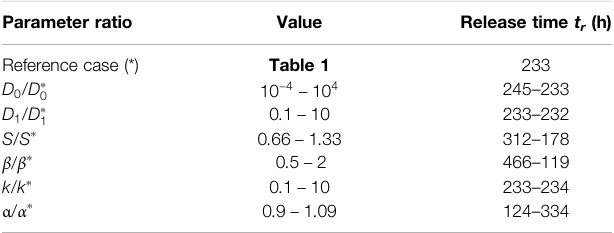
TABLE 2 | Parameter variations over the reference case and their in fl uence on the release time t r . Parameter ratio